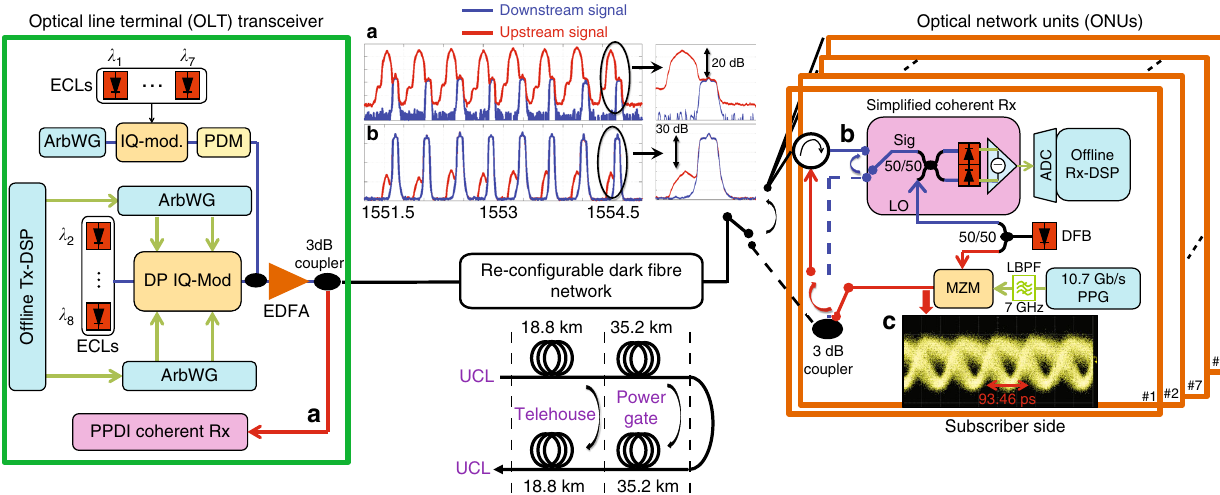
Fig. 3 Bidirectional 8-channel 50 GHz-spaced dense WDM-PON transmission test-bed. The downstream channels were modulated with a 10.7 Gb/s Alamouti-coded OFDM QPSK and 16-QAM, whereas 10.7 Gb/s BPSK signal whose eye diagram was shown in the inset c was used for upstream channels. The frequency offset between the downstream and upstream channels was chosen to be 12.5 GHz, as shown in the insets a , b . The network was con fi gured to fi rst 37.6 (from UCL to Telehouse and back to UCL) and then 108 km (from UCL to Power gate via Telehouse and back to UCL via the same route). When the transmission distance was set to 108 km, the control switch in the ONU was changed from the 3-dB coupler to the optical circulator. It is worth noting that particularly in the ONU, a 3-dB coupler, which has 20 – 30 dB less isolation compared to an optical circulator, is more preferable. Blue lines indicate the downstream signal, whereas the upstream optical signal is represented using red lines . Insets: The received optical spectra in the a ONU and b OLT at 108 km. c Eye diagram of 10.7 Gb/s BPSK signal. LPF: low-pass fi lter, PDM: polarisation-division multiplexing, PPDI Rx: polarisation-and phase-